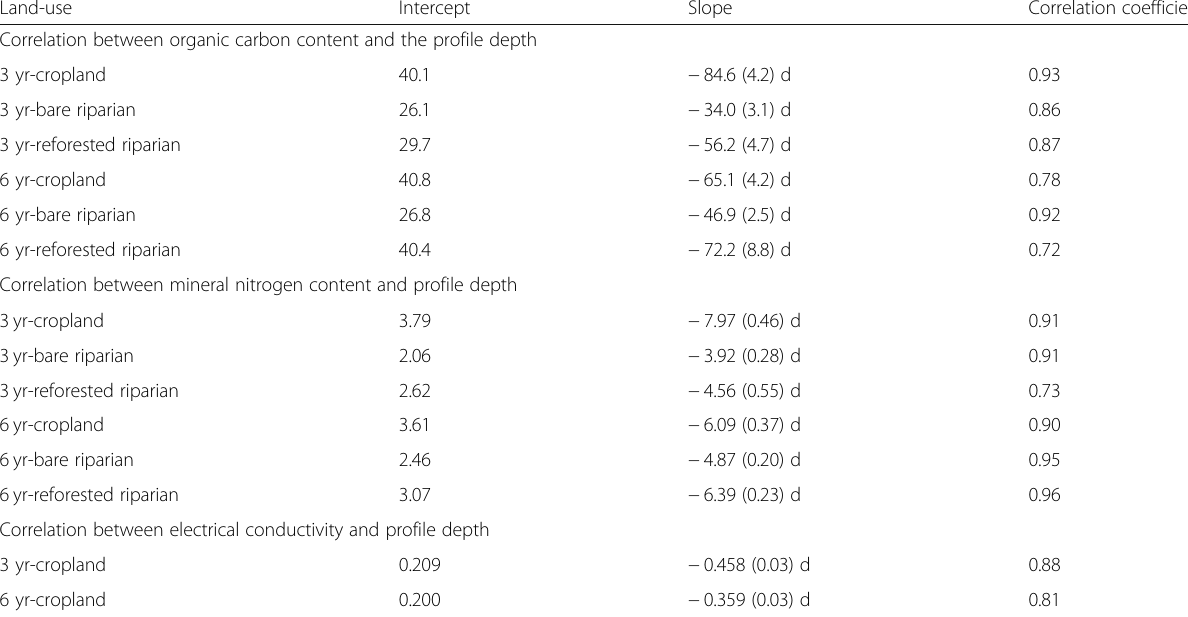
Table 3 The summary for the simple linear correlation analysis performed between the mean soil attribute content in a given profile section and the corresponding profile depth to determine whether the distributions are impacted by land-use practices